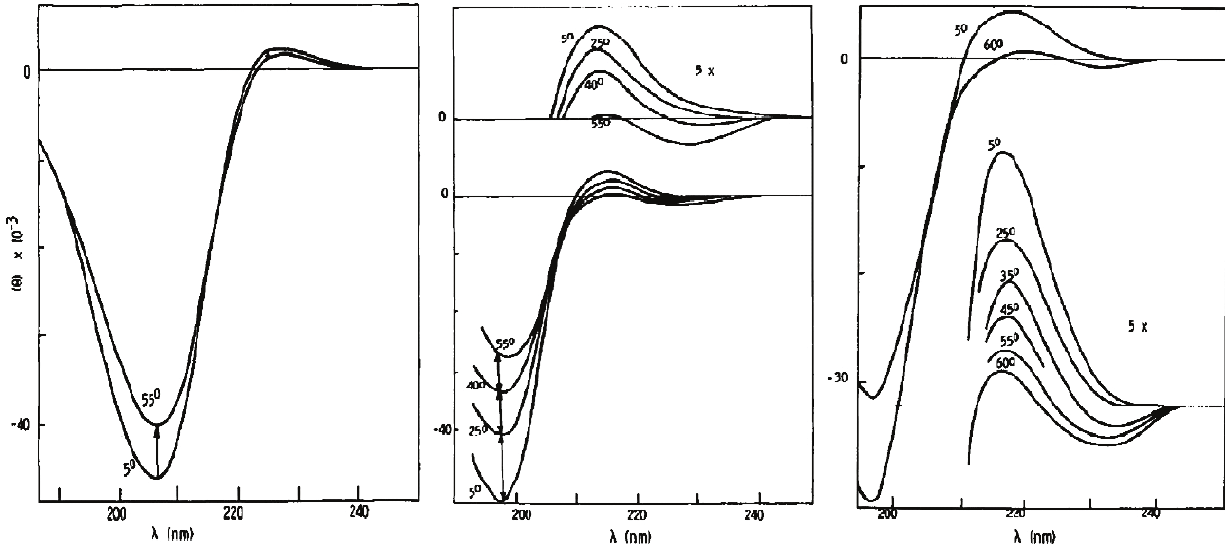
Figure 3. ( left panel ): Ultraviolet circular dichroism (UVCD) spectra of poly- L -proline II, ( middle panel ): poly- L -glutamic acid, and ( right panel ): poly- L -lysine measured as a function of temperature which show a characteristic pPII signals. (Taken and modified form from